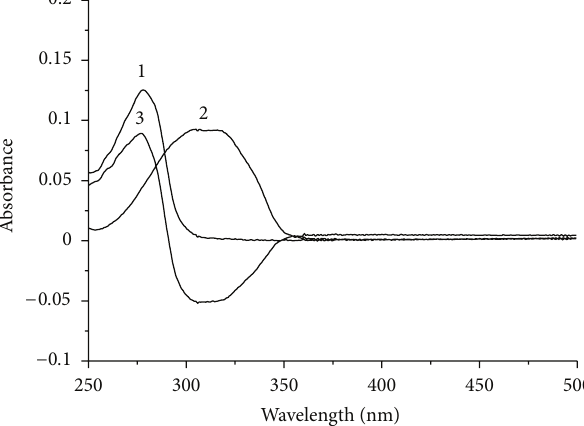
Figure 3: UV-vis absorption spectra of BSA (1) , TRES (2) , and the difference spectrum between TRES-BSA and TRES (3) . 𝐶 = 3.0 × 10 −5 molL −1 ; pH = 𝐶 TRES